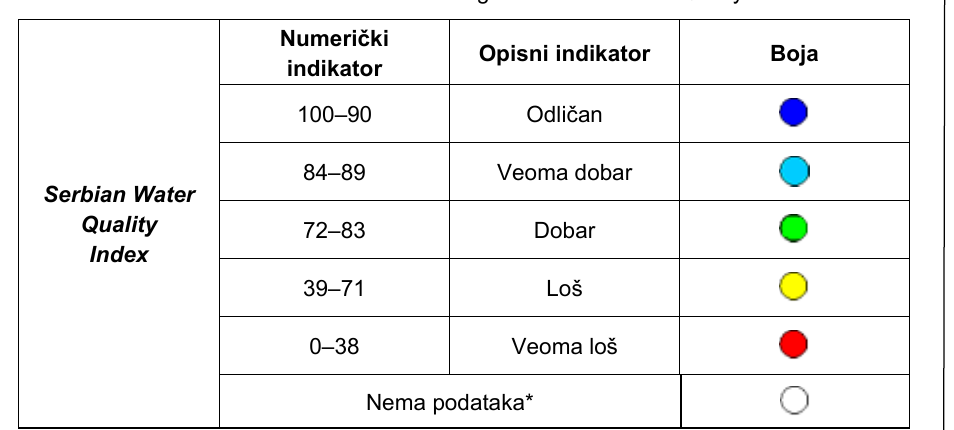
Classification of surface waters using the Serbian Water Quality